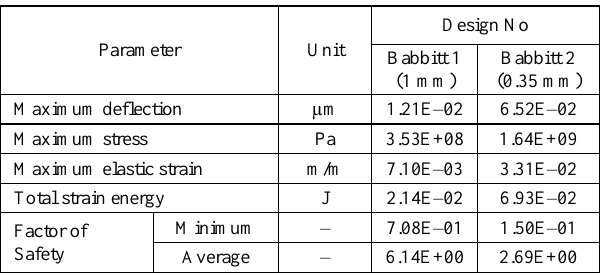
Table 1. Comparison of the results for each Babbitt